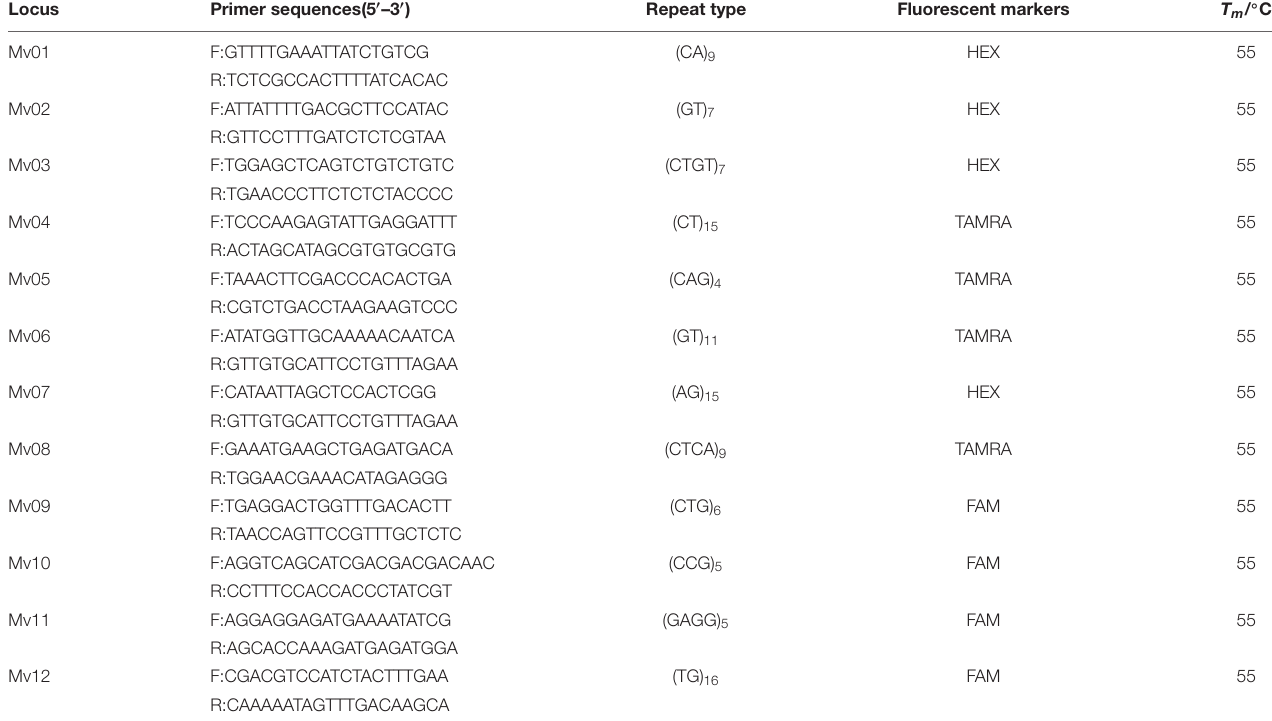
TABLE 2 | Characteristics of the 12 microsatellite primers. Locus Primer sequences(5 (cid:48) –3 (cid:48) ) Repeat type Fluorescent markers